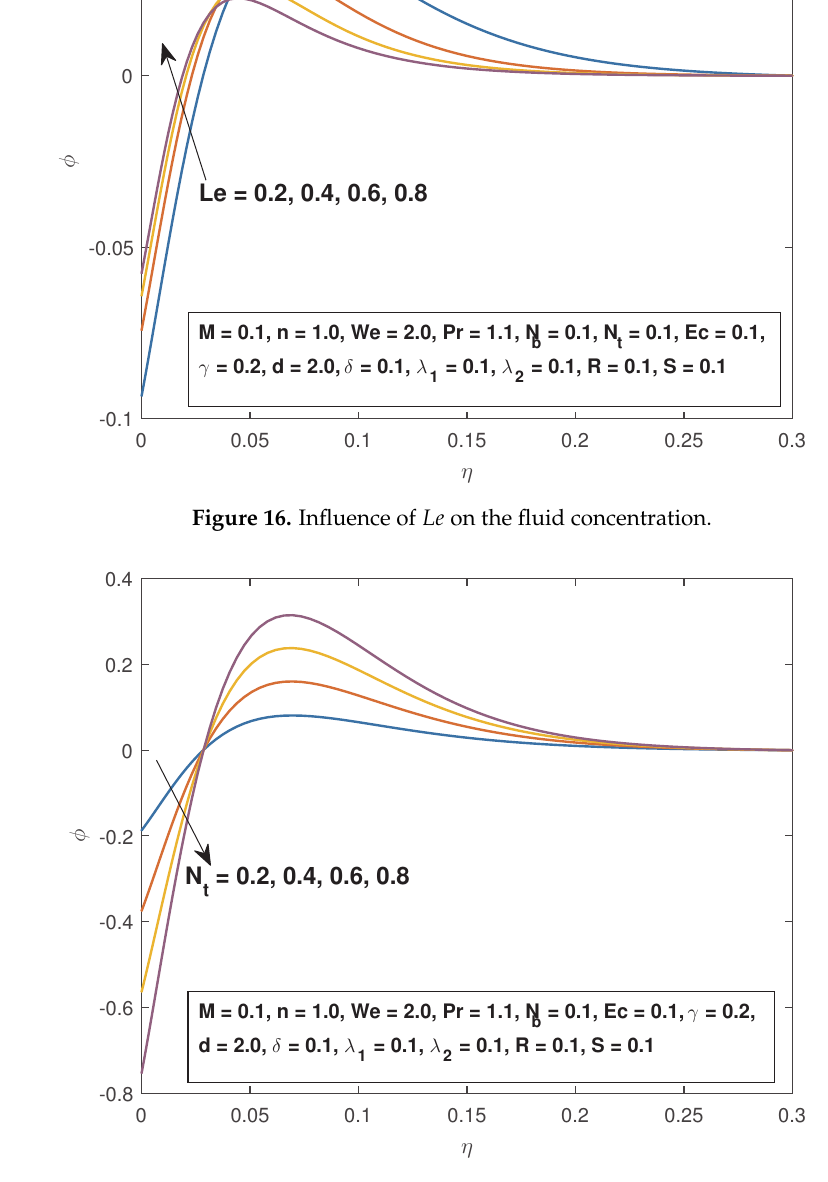
Figure 17. Influence of N t on the fluid